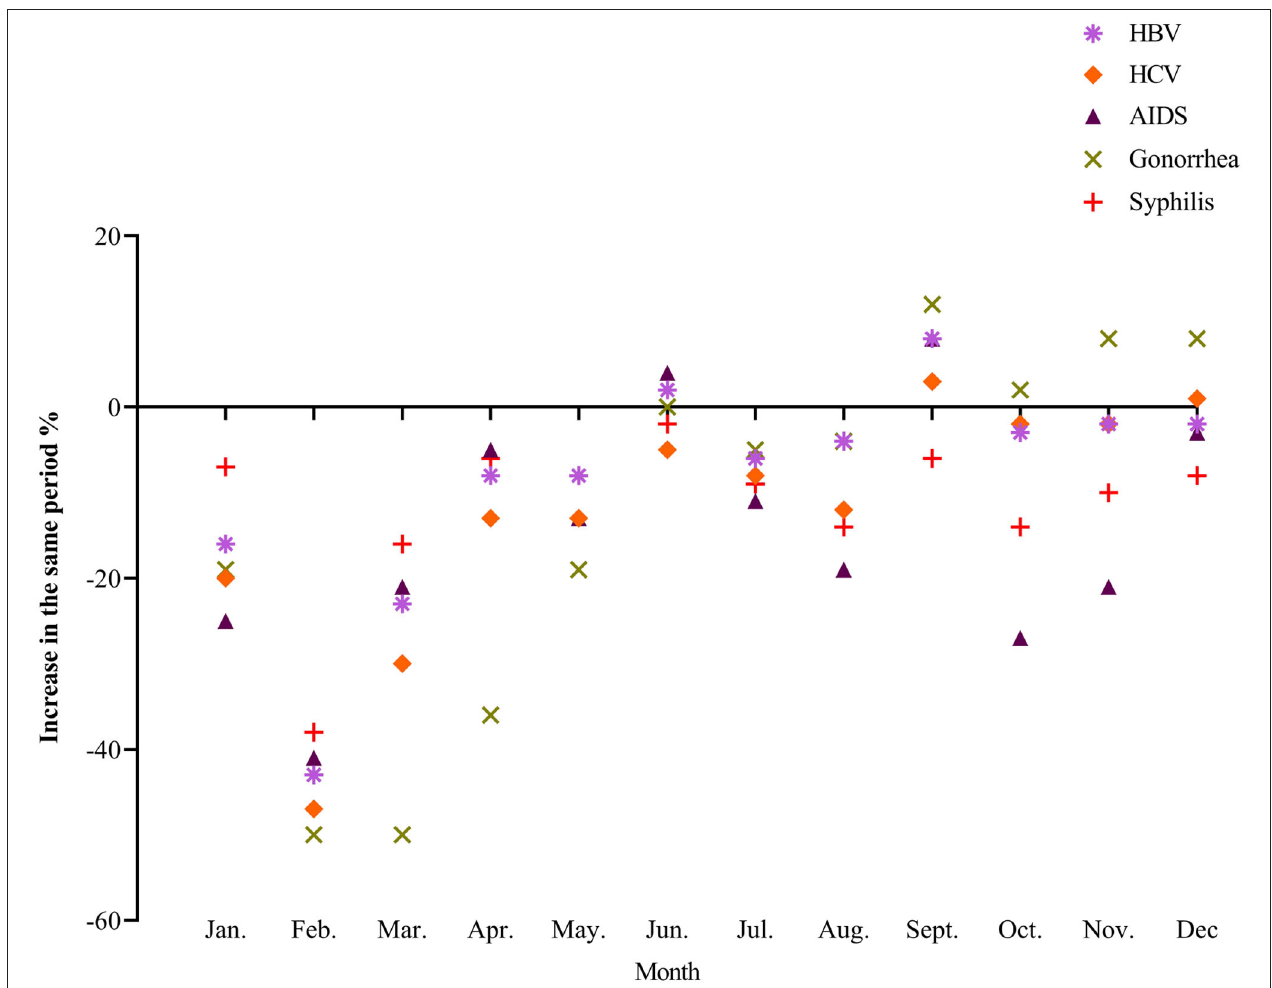
FIGURE 5 | The incidence trend of common blood-origin and sexual transmitted diseases in